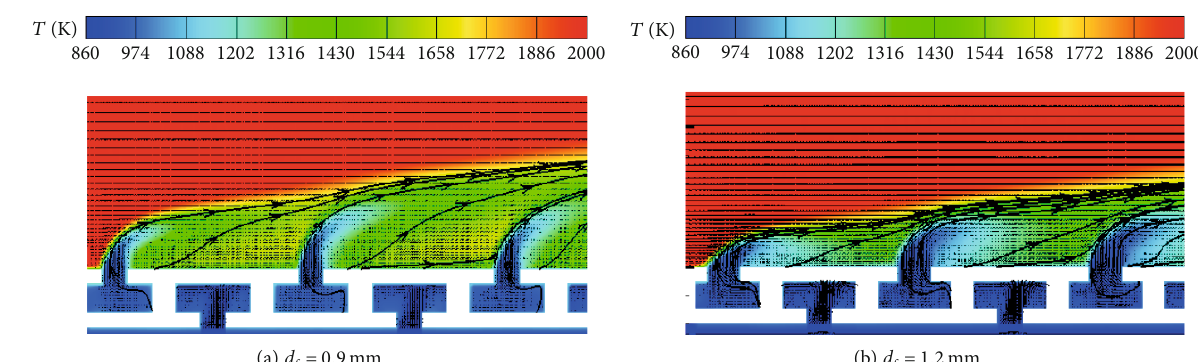
Figure 14: E ff ect of fi lm hole diameter on streamline distribution on central plane.